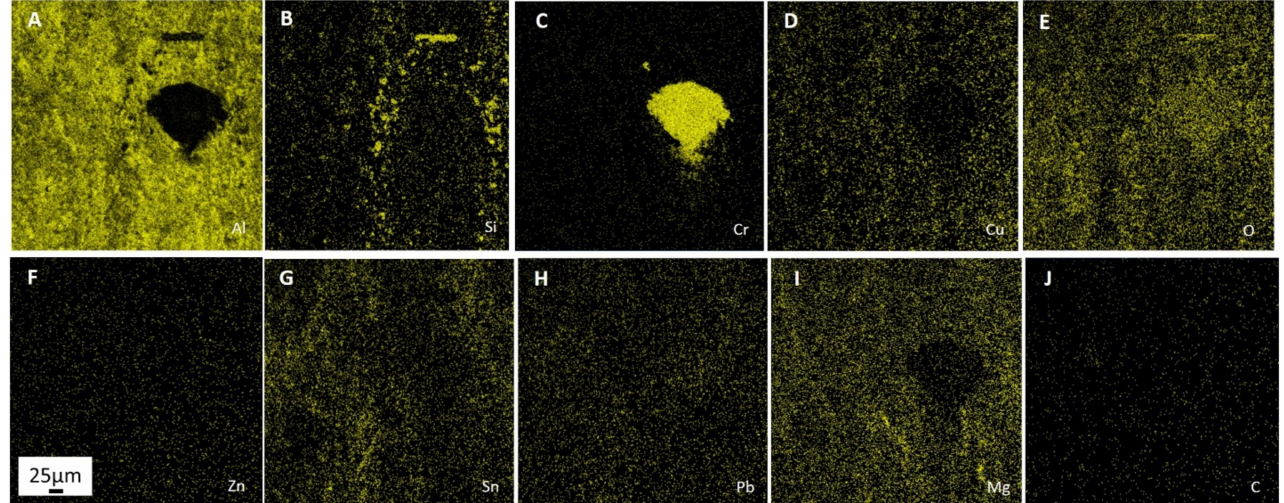
Figure 9. SEM-EDS elemental distribution maps Al–Cr alloy after tribological test for aluminum ( A ), silicon ( B ), chromium ( C ), copper ( D ), oxygen ( E ), zinc ( F ), tin ( G ), lead ( H ), magnesium ( I ), and carbon ( J ). The scale in Figure F also applies to rest of images (scale: 25 µ m).